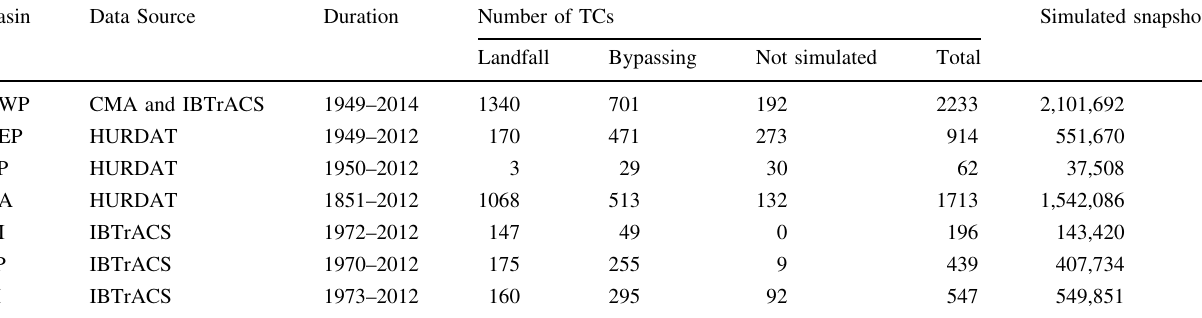
Table 4 Statistics for the simulated global tropical cyclone best track datasets by basin